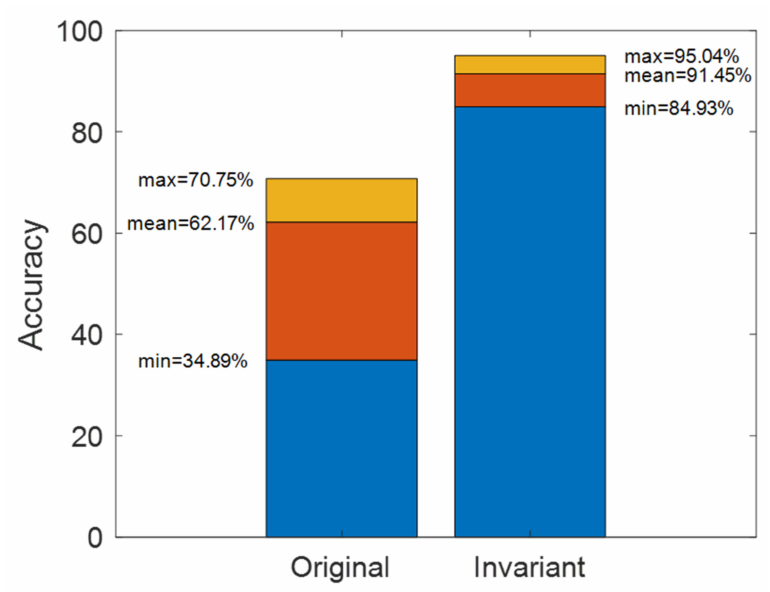
Figure 10. ResNet testing performance comparison between original and invariant